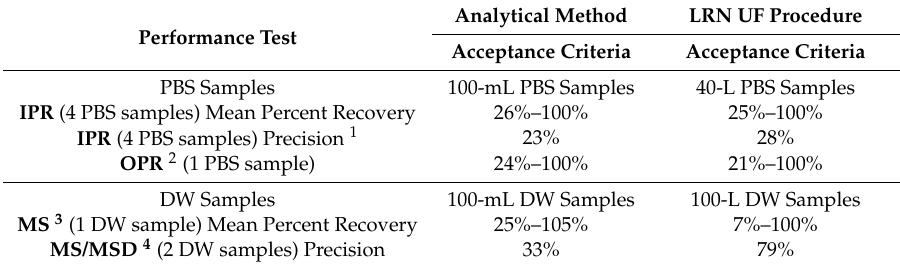
Table 7. Warning tool–IPR, OPR, MS and MS/MSD criteria for analytical method (100-mL samples) and LRN UF procedure (40-L PBS and 100-L DW samples) based on 90% prediction